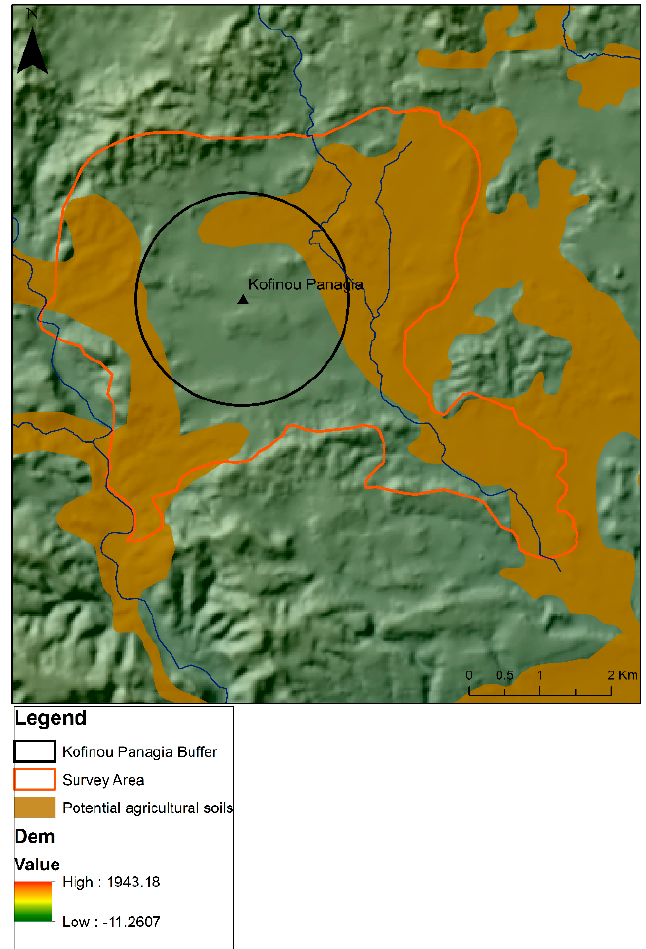
Figure 9. Best agricultural soils in the Xeros valley according to the Soil Atlas of Europe . Image© SeSaLaC (digital geological data courtesy of the Geological Survey Department, Republic of Cyprus; map drafted by N. Kyriakou).